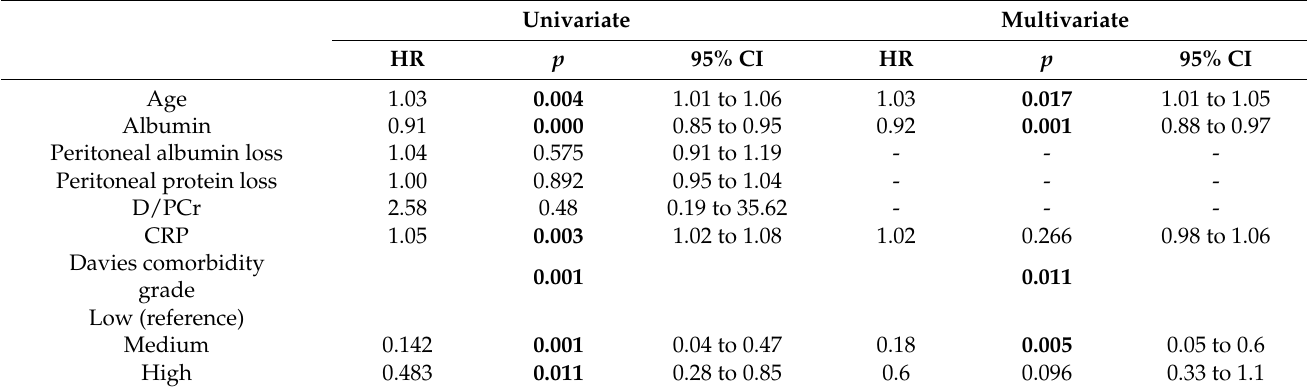
Table 5. Cox regression analysis for